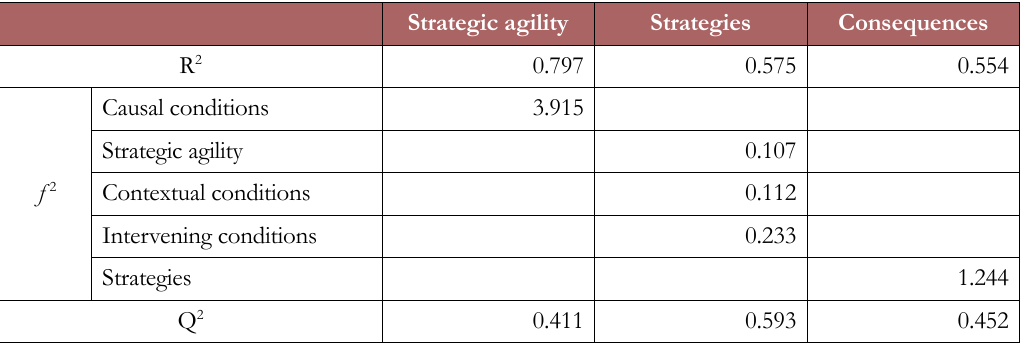
Table 15. Assessment and predictive criteria